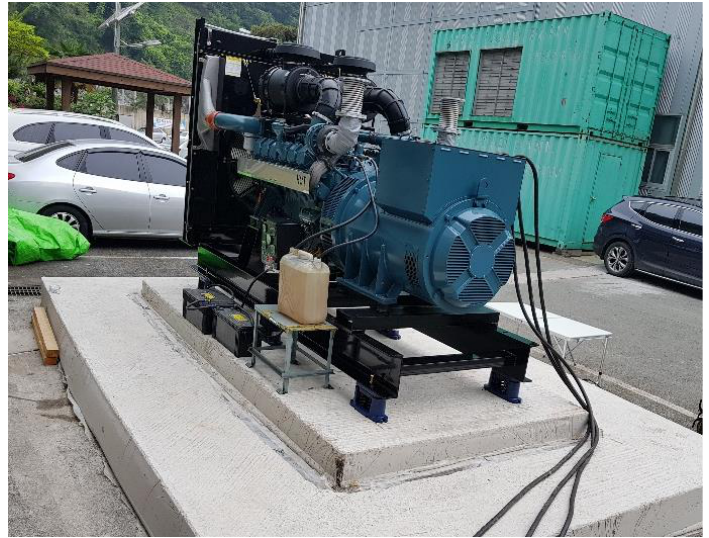
Figure 1. Image of the electric power generator [20].